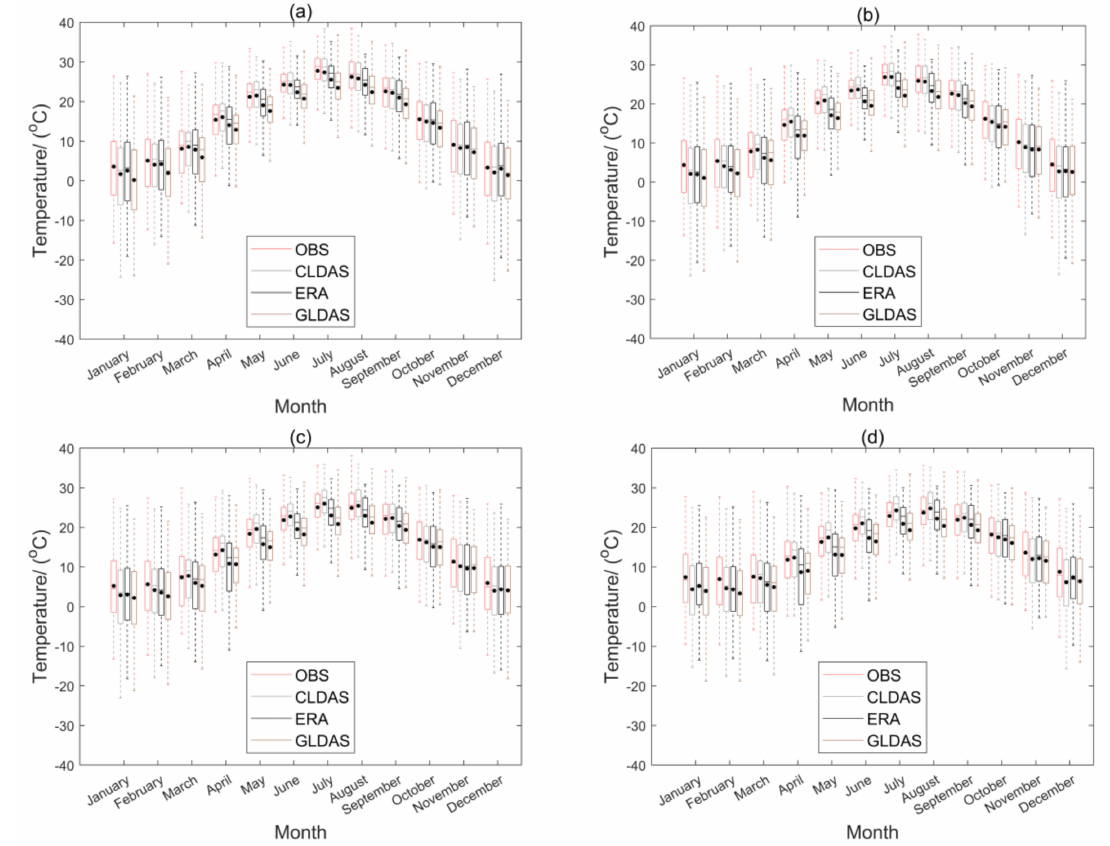
Figure 6. Box-and-whisker plots showing the minimum; 25th, 50th, and 75th percentiles; and the maximum values of monthly averaged observations and CLDAS, ERA-Interim, and GLDAS datasets of ST10 ( a ), ST20 ( b ), ST40 ( c ), and ST80 ( d ). The black dot in each box indicates the mean value of